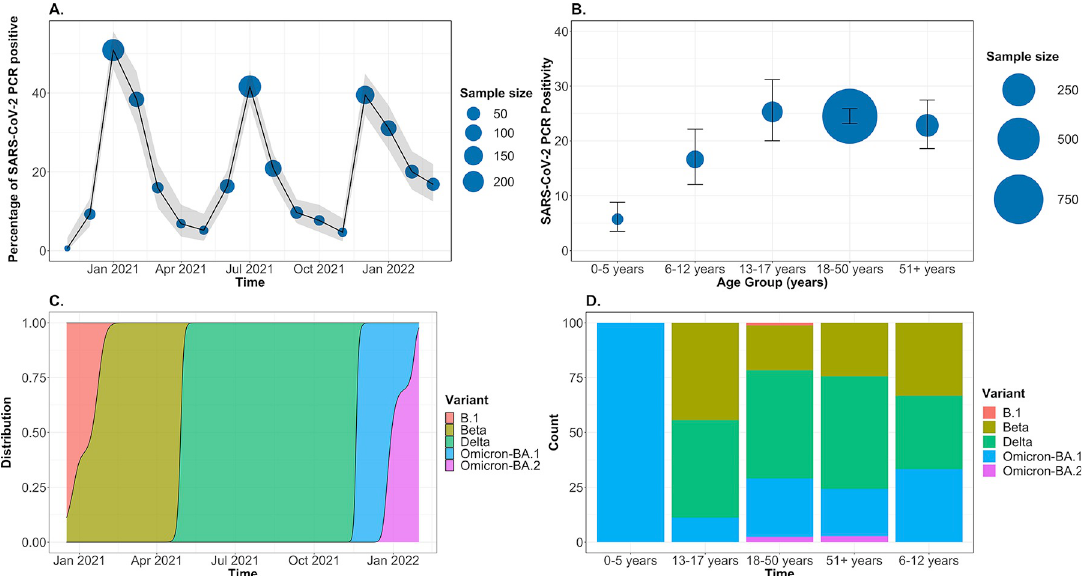
Fig 1. Prevalence of SARS-CoV-2 infections. A) Prevalence of SARS-CoV-2 infections across age groups. B) Prevalence of SARS-CoV- 2 infections over time. Grey area represents confidence intervals. C) SARS-CoV-2 variants of concern across the three pandemic waves. D) SARS-CoV-2 variants of concern across age groups. (n =